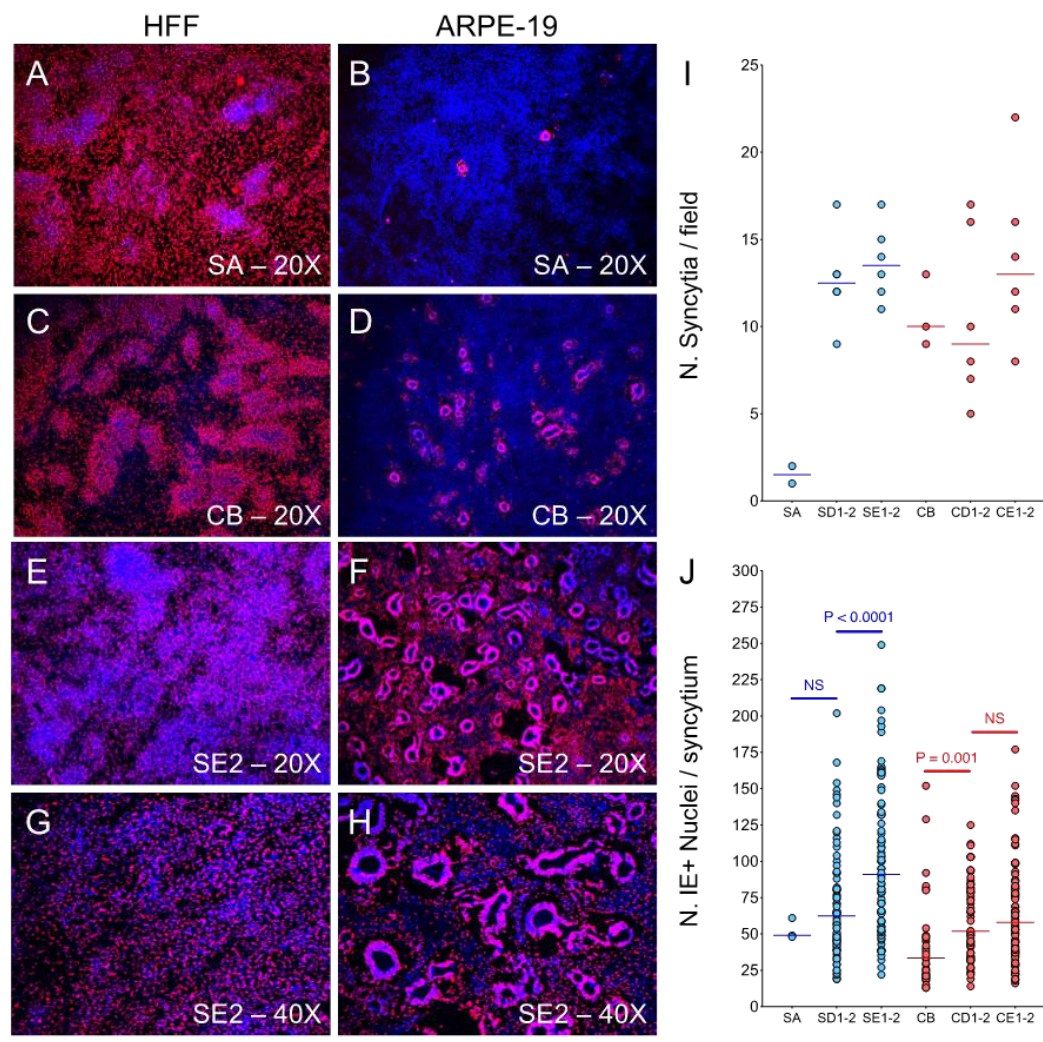
Figure 5. Development of syncytia in infected ARPE-19 cultures. HFF and ARPE-19 populations were infected at an MOI of 0.01 pfu/cell, fixed and stained at day 11 pi for IE. ( A-H ) Micrographs of infected populations stained with an anti-IE antibody (red) and with Hoechst 33342 to visualize nuclei (blue). Signal overlap appears in purple. Images were taken at a 20 × or 40 × magnification. ( I ) Number of syncytia and ( J ) number of IE+ nuclei per syncytium detected in 3 different, randomly selected fields of ARPE-19 cells infected with virus stocks listed on the X axis. Bars correspond to median values; p values correspond to Mann–Whitney comparison tests. NS = not significant.